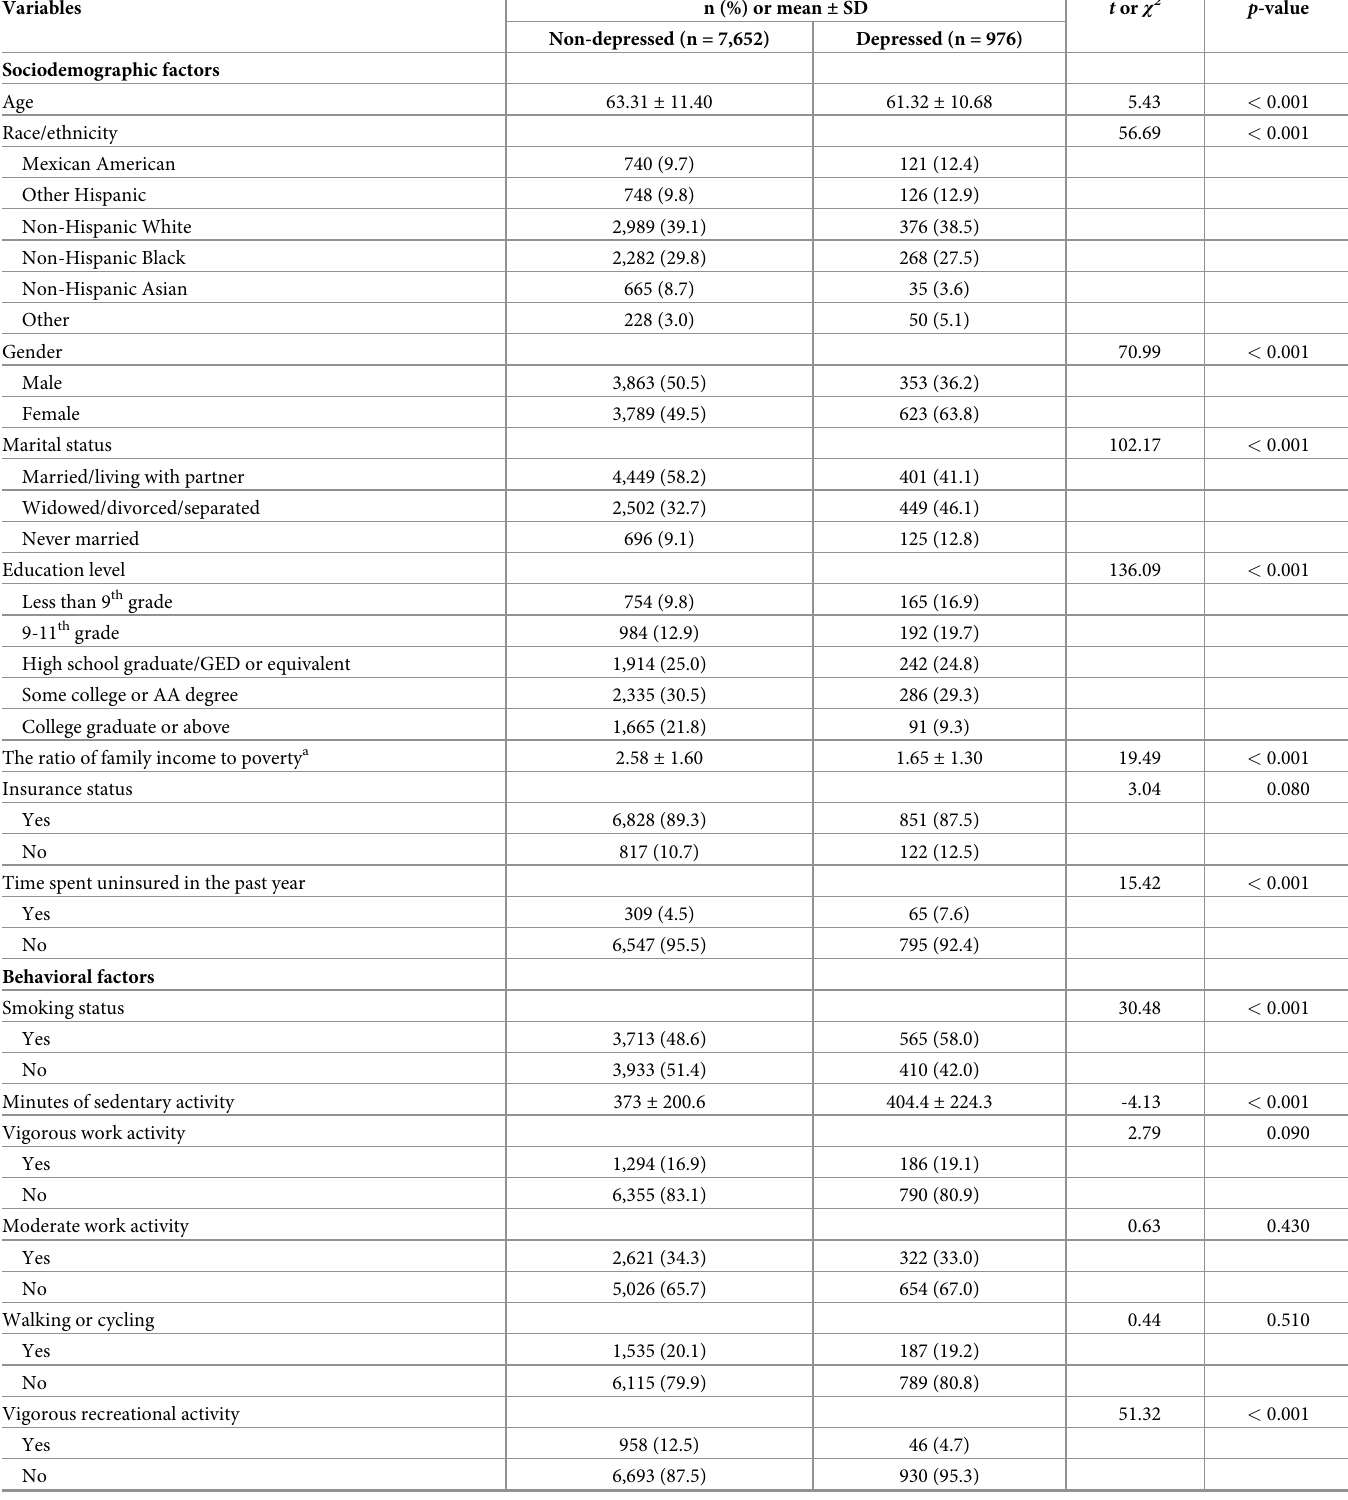
Table 2. Comparison of baseline characteristics